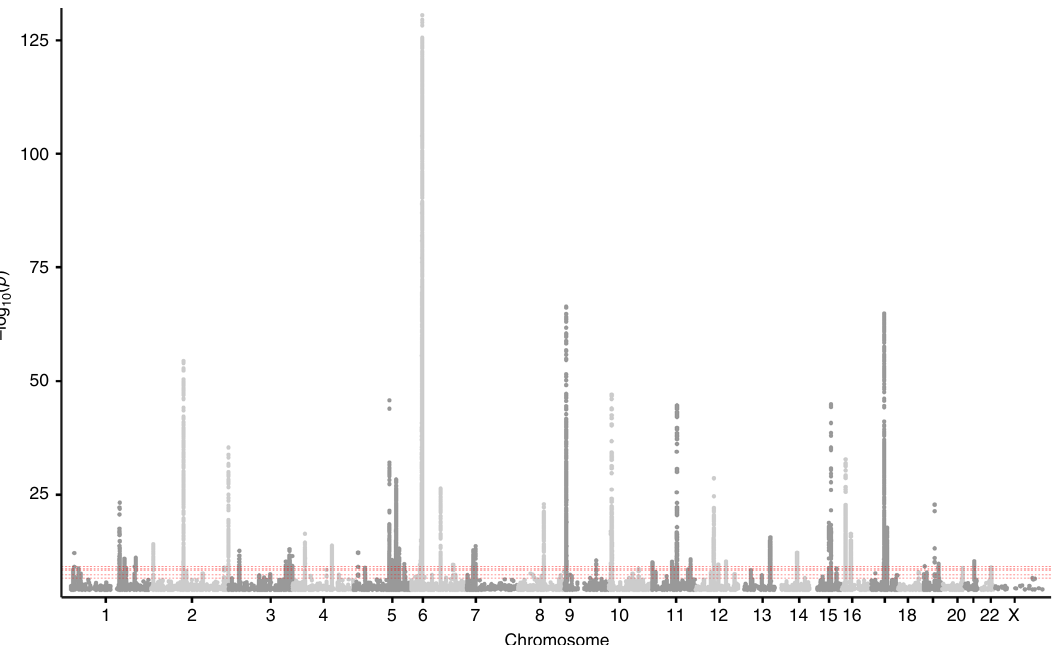
Fig. 1 Sequence variants associating with asthma. Manhattan plot for the Iceland-UK BB meta analyses of asthma ( N cases = 69,189). In all, 56 regions harbor genome-wide signi fi cant signals. Variants are plotted by chromosomal position ( x -axis) and − log 10 P values ( y -axis). Dotted line indicate the different P value thresholds applied based on variant annotation. The adjusted signi fi cance thresholds are represented by horizontal dashed line from bottom to the top in the following order: 2.6 × 10 − 7 for variants with high impact ( N = 8,464), 5.1 × 10 − 8 for variants with moderate impact ( N = 149,983), 4.6 × 10 − 9 for low-impact variants ( N = 2,283,889), 2.3 × 10 − 9 for other variants in DNase I hypersensitivity sites ( N = 3,913,058) and 7.9 × 10 − 10 for all other variants ( N =